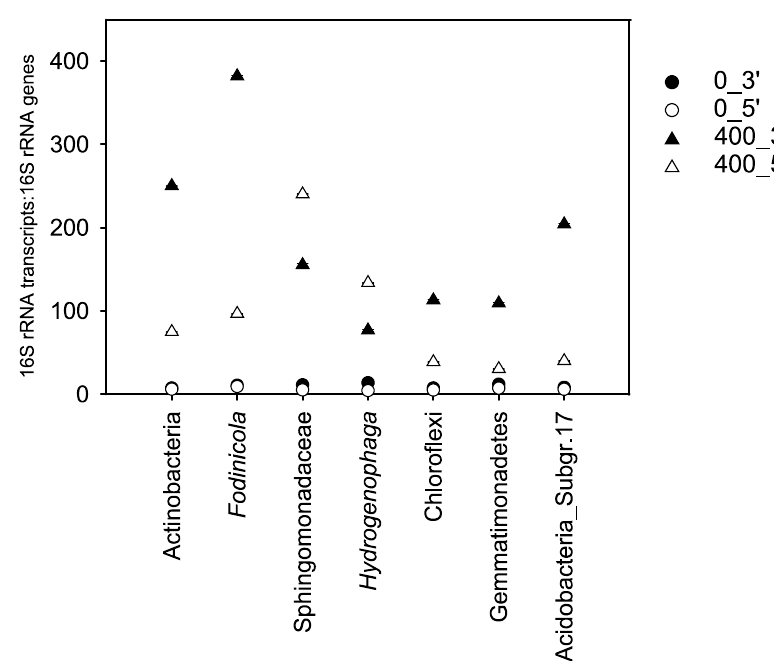
Figure 5. 16S rRNA (cDNA) to 16S rRNA gene ratios determined by qPCR for selected taxa stimulated by ibuprofen in the 400 µM treatment (Figures 1, and 4) as an indicator of taxon-specific activity. Values are the arithmetic means of triplicate incubations. Error bars indicate the standard deviation but are smaller than the symbol size and therefore not apparent. Sample code: 0 and 400 indicate supplemental ibuprofen concentrations in µM given per feeding; 3 ′ and 5 ′ correspond to samples obtained after the third and fifth refeeding, respectively. Sampling times for unamended controls were according to those of the 400 µM ibuprofen treatment.